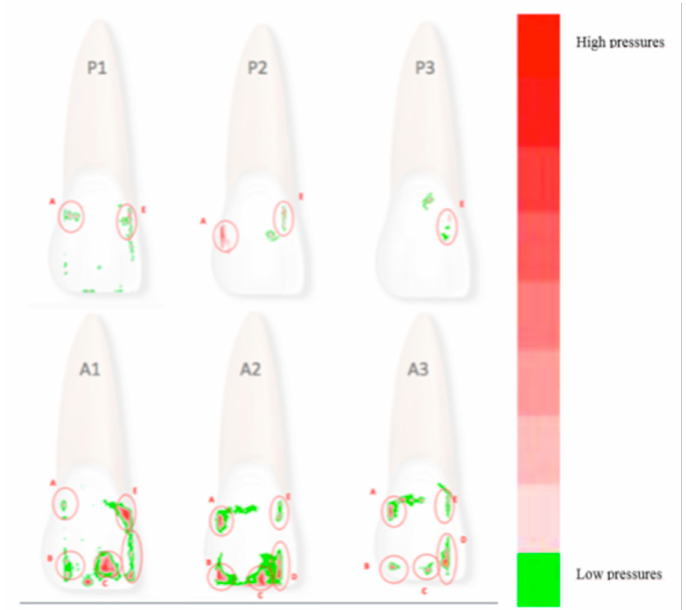
Figure 3. P1, P2 and P3: areas of pressure revealed by Super Low Pressure (SLP) film with passive aligners. A1-A2-A3: areas of pressure revealed by Low Pressure (LP) film with active aligners. The di ff erent colours correspond to di ff erent pressure values. The green scale indicates minimum pressure values while the red scale indicates maximum pressure values. The active values were later adjusted by subtracting the passive values for calibration purposes. Table 1. Mean and maximum pressure obtained for the three passive aligners (P1, P2 and P3) during the calibration phase. P1 P2 P3 Pressure Areas